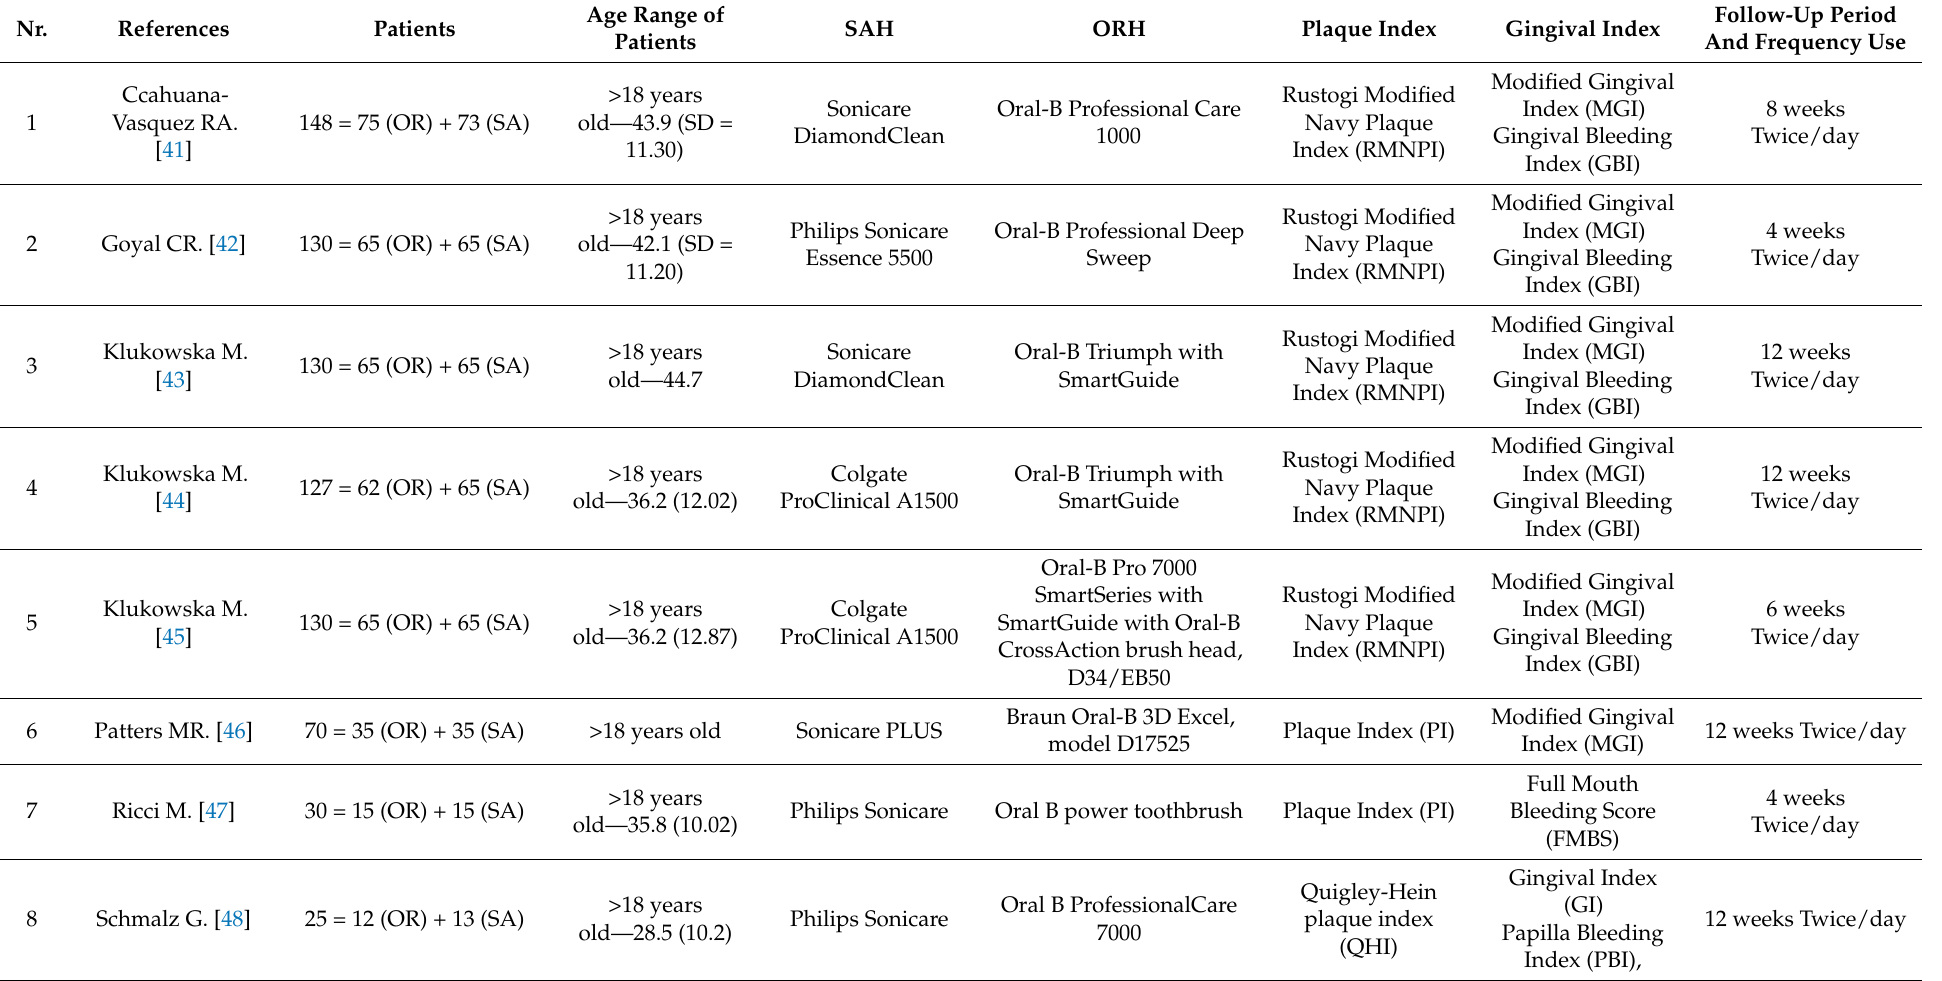
Table 2. All studies included for the qualitative